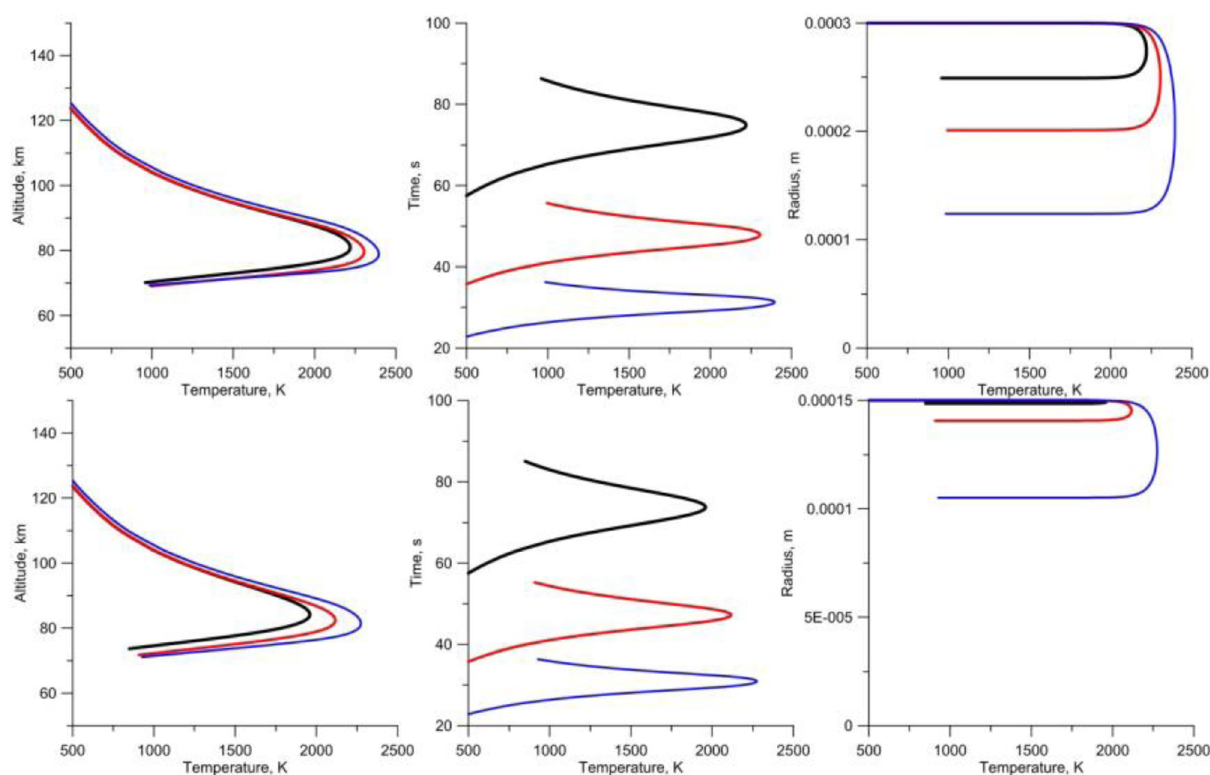
Fig. 5 Ablation of Antarctic microtektites during re-entry. Particles entering the atmosphere with different velocities and angles can heat and ablate. Upper plots are for a particle radius of 300 μ m, the lower ones for a particle radius of 150 µ m. Black: velocity of 7.4 km s − 1 , re-entry angle of 15°; red: 7.4 km s − 1 , angle of 27°; blue: 8 km s − 1 , angle of 42°. All combinations of angle/velocity result in deposition at ~11,000 km from the source